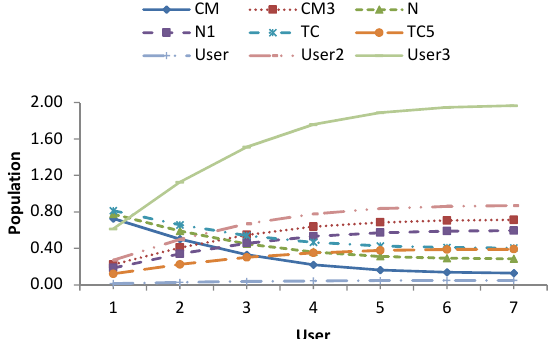
Figure 3: The population of the VM Launch Model, where the probability of trust ( p = 0 . 2)